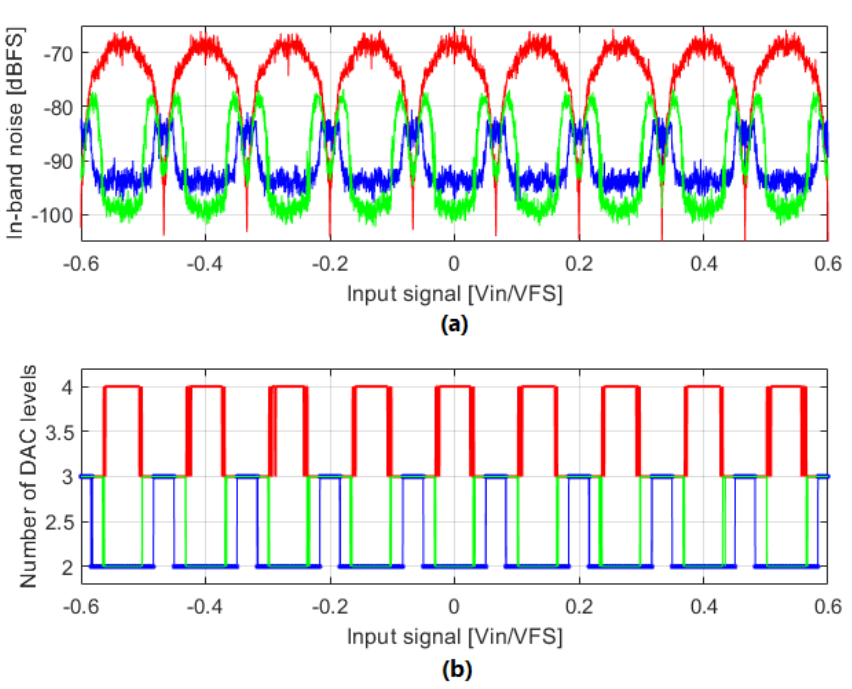
Figure 5. ( a ) IBN power and ( b ) number of used DAC levels. Σ∆ M common parameters are: third- order, 4-bits, OSR = 32, BW = 20 kHz. OBG values are 1.5 (blue), 1.8 (green), and 2.5 (red). Input signal is a slow ramp whose slope is 91.5 mV/s. Output signal is divided in segments of 3.2 ms. e LIN and e Q are